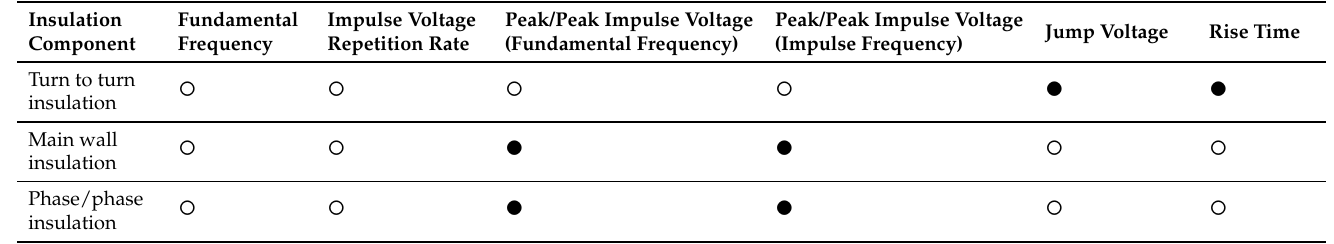
Table 1. Influence of the features of machine terminal voltage on components of Type I insulation